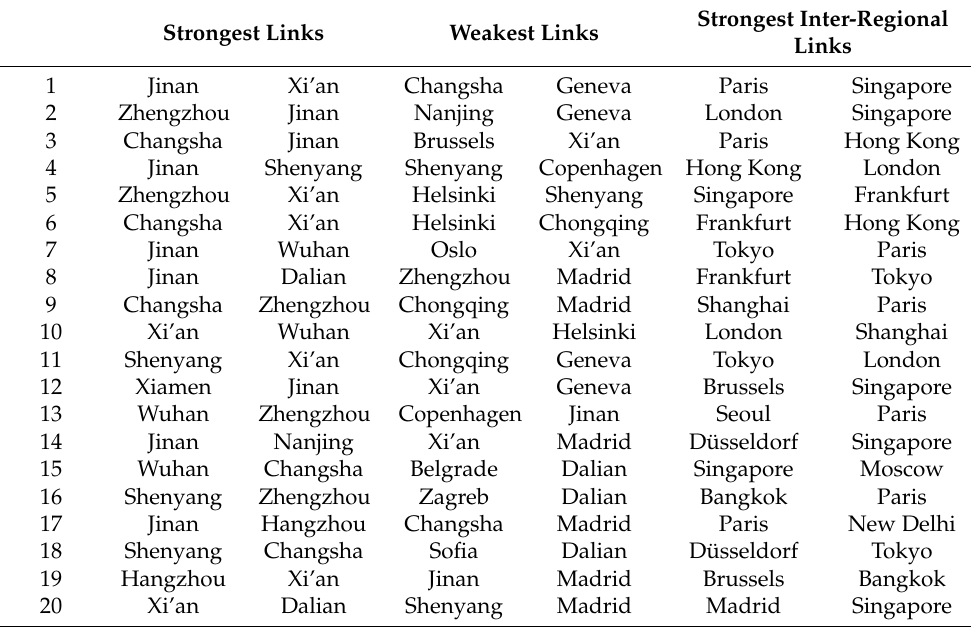
Table 4. An overview of the 20 strongest and the 20 weakest RCDCa-i